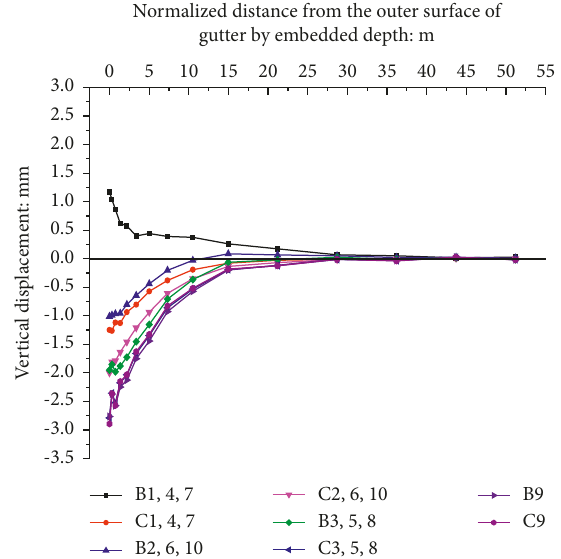
Figure 15: Vertical displacement profile on the ground surface along Gutter 7 during the construction of